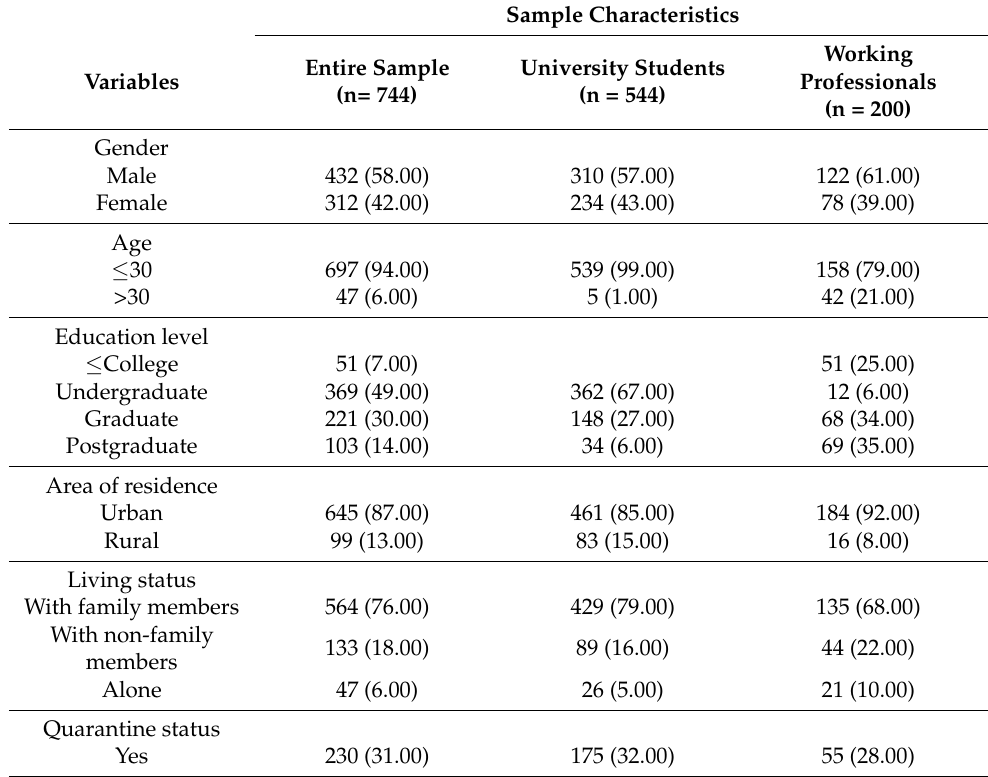
Table 1. Descriptive statistics of respondents (n =